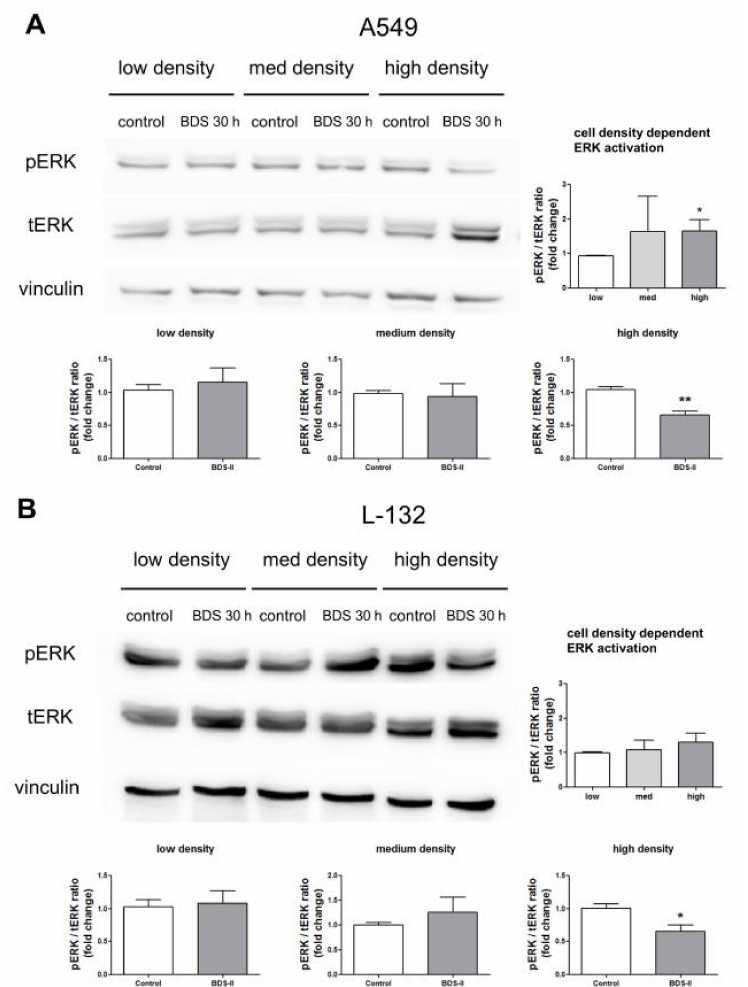
Figure 7. Effect of BDS-II on ERK activation according to the increase in cell density. ERK activation according to the increase in cell density was analyzed in A549 and L-132 cells using the ratio of phosphorylated ERK (pERK) to total ERK (tERK) protein expression. ( A ) Quantitative data demonstrate that ERK was activated in A549 cells cultured at a high density compared with A549 cells cultured at a low density. ERK activation in medium-density A549 cells did not significantly differ from that in low-density A549 cells. ( B ) ERK activation was not altered according to the cell density in L-132 cells. When the cells were incubated with 500 nM BDS-II for 30 h, ERK activation in the high-density A549 or L-132 cells was inhibited. BDS-II had no effect on ERK activation in A549 or L-132 cells cultured at either a low or medium density. All experiments were performed in triplicate, and the data represent the mean ± standard error. * p < 0.05 and ** p < 0.01 versus the low-density or control